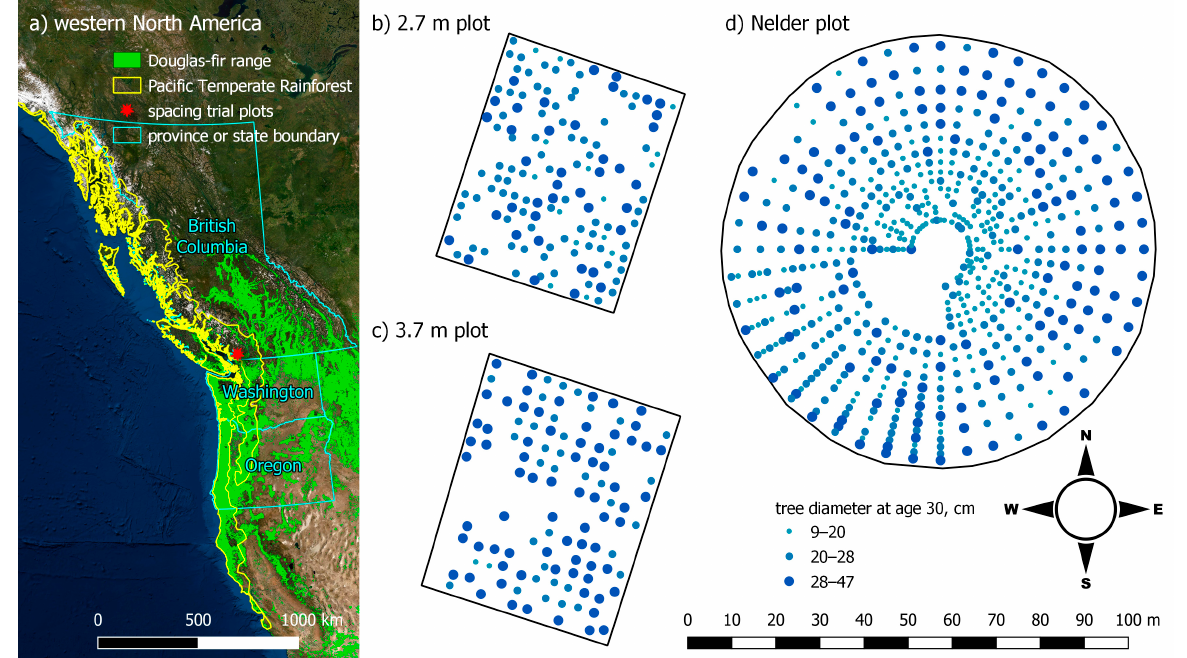
Figure 1. ( a ) Location of study area [20,21] and ( b – d ) stem maps of live trees on the 2.7 m, 3.7 m, and Nelder spacing trial plots, respectively, used for model initialization as of their measurement at age 30 years. Plots are shown to scale, but their placement relative to each other is not shown. Spacing in the Nelder plot varies from 0.91 to 4.94